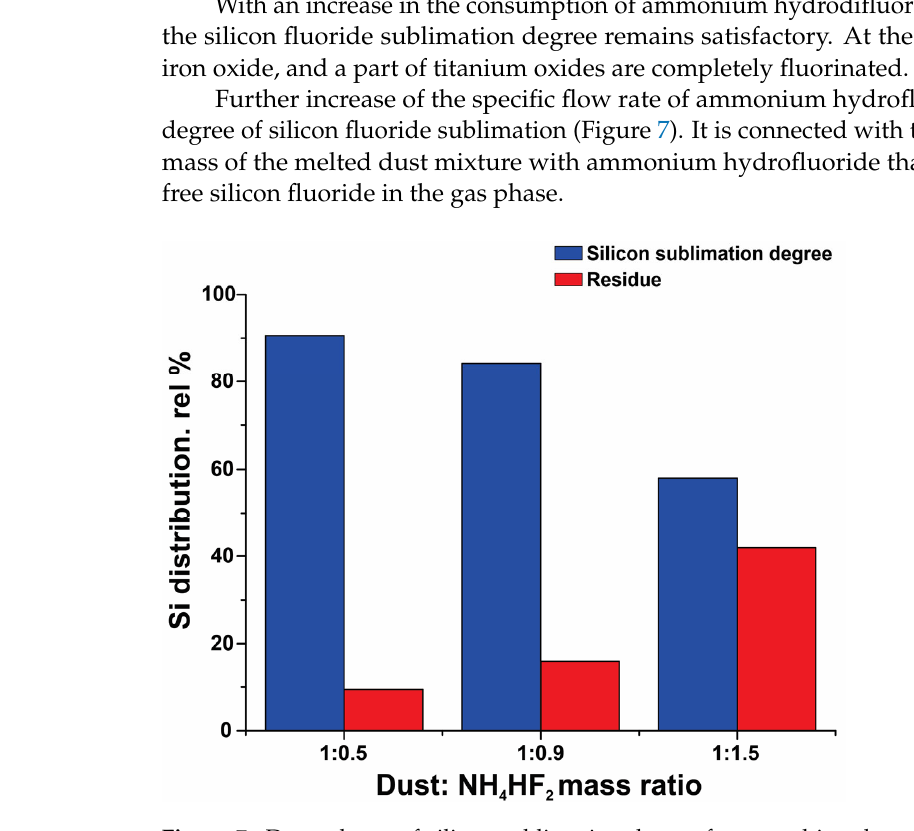
Figure 7. Dependence of silicon sublimation degree from smelting dust of ilmenite concentrate dur ‐ ing fluorination on specific flow rate of ammonium